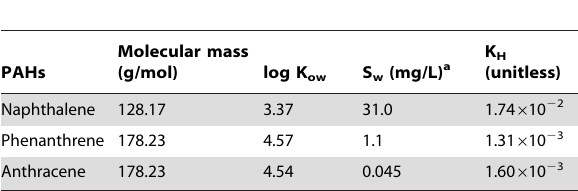
Table 1. Selected physicochemical properties of the PAHs used in this study [33].